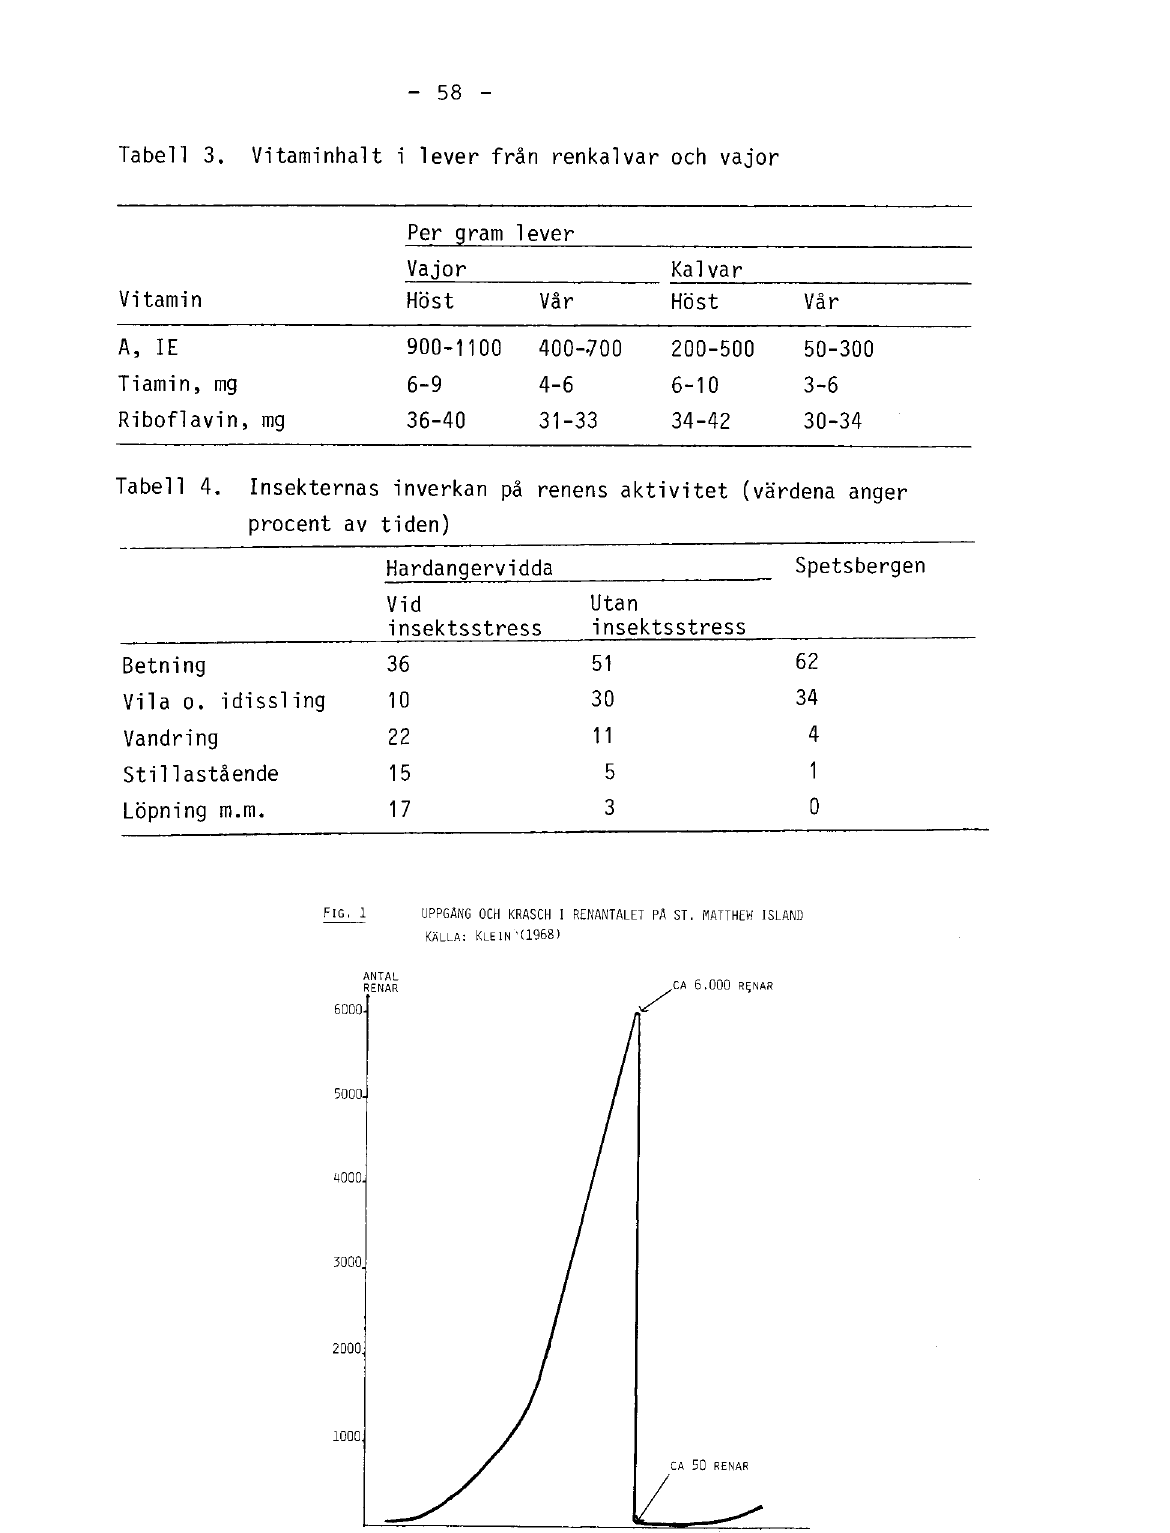
Tabell 3. Vitaminhalt i lever från renkalvar och